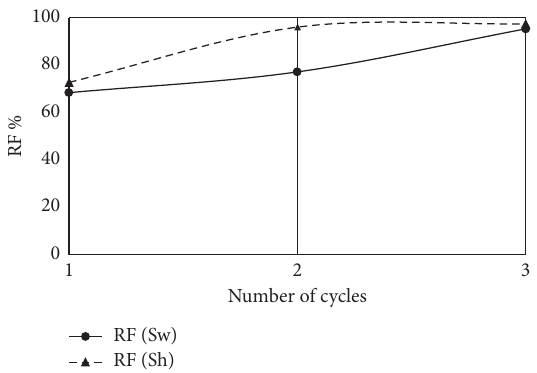
Figure 13: Time required for each stage of the cycle for